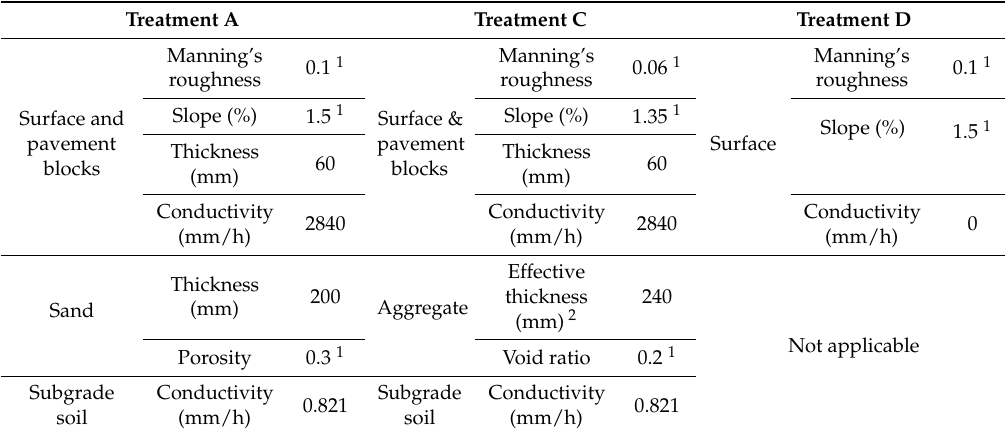
Table 2. Input parameters of the pavement types for calibration and